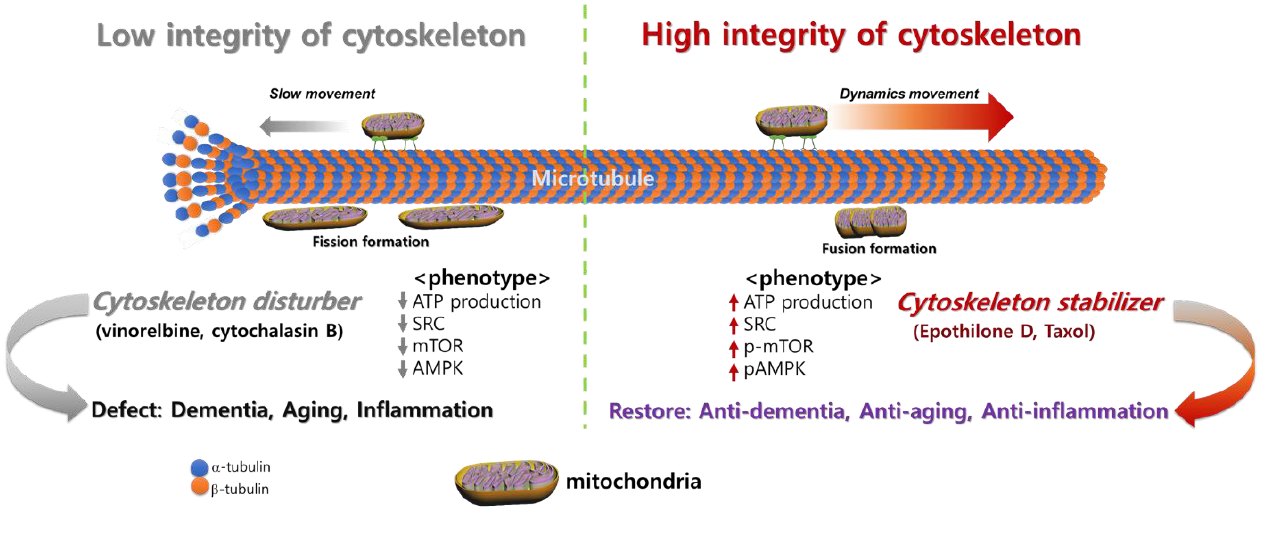
Figure 2. Degeneration, aging, and inflammation associated with integrity of microtubules and dynamic movement of mitochondria.